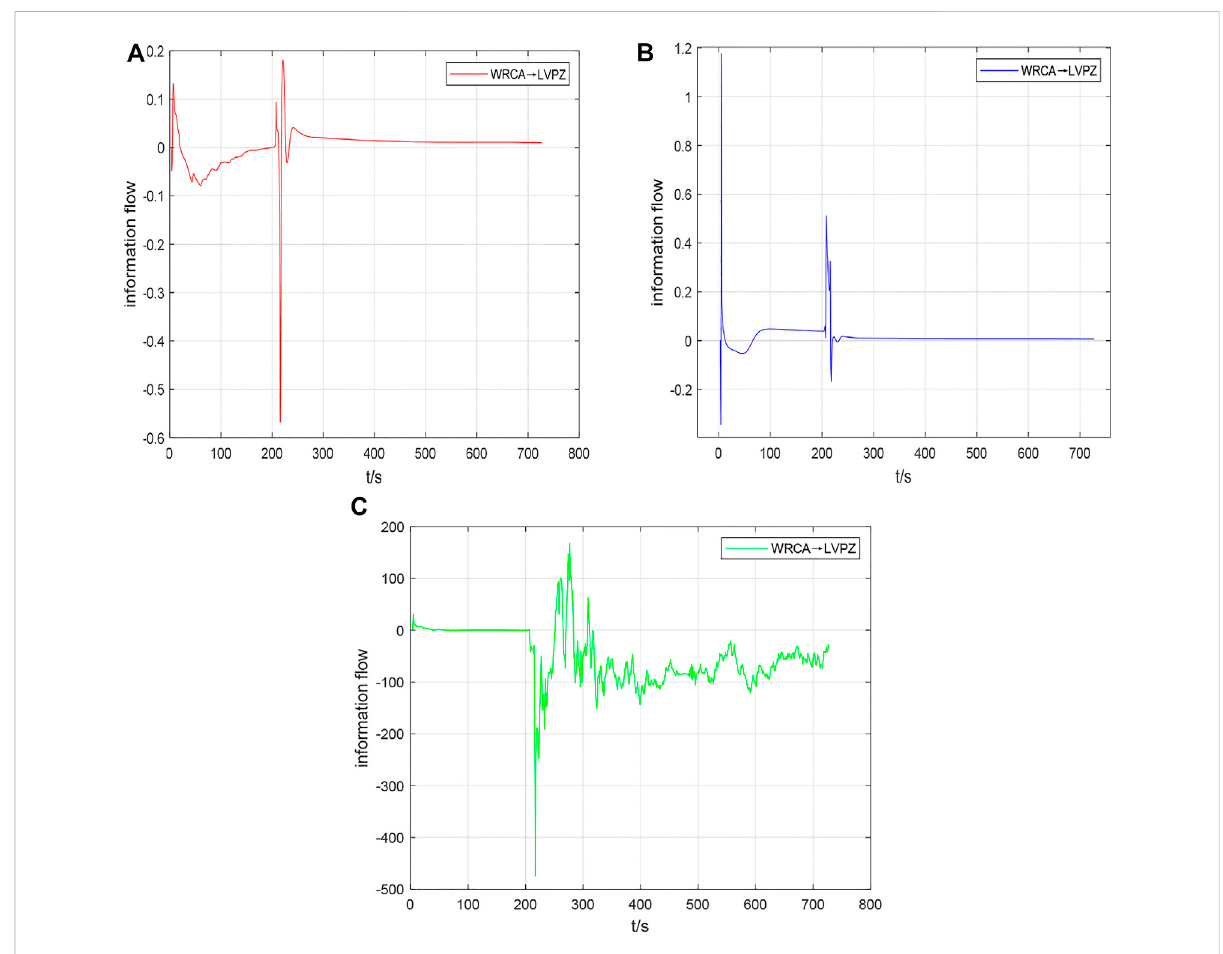
FIGURE 11 Sub-information fl ow of MSLB-IN with 10% breach size in 200s.